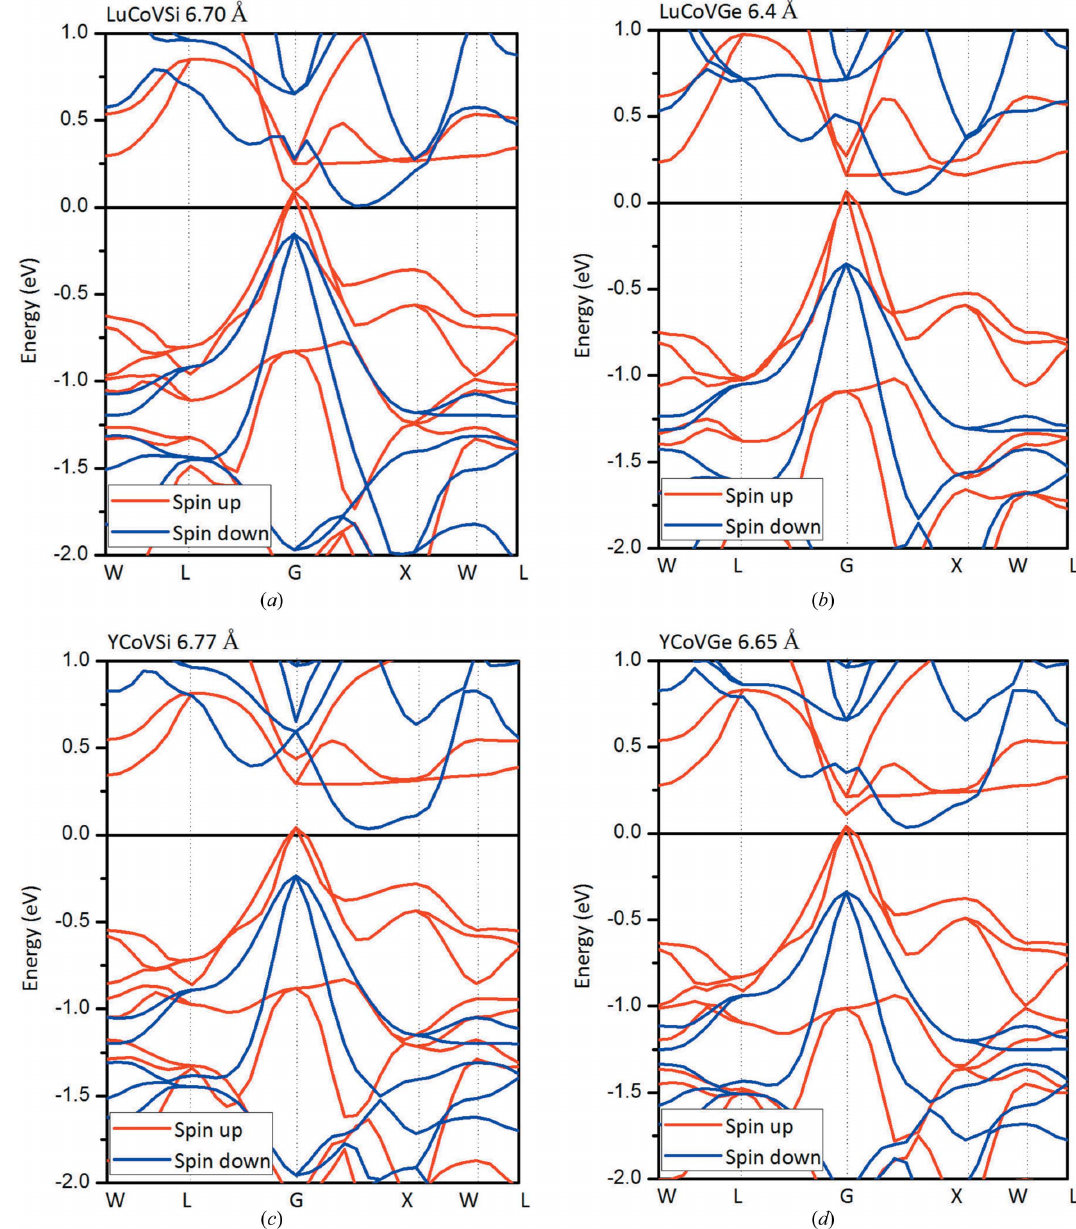
Figure 9 Calculated band structures for the rare earth-containing EQH compounds ( a ) LuCoVSi, ( b ) LuCoVGe, ( c ) YCoVSi and ( d ) YCoVGe at their strained lattice constants. The half-metallic properties of these compounds are